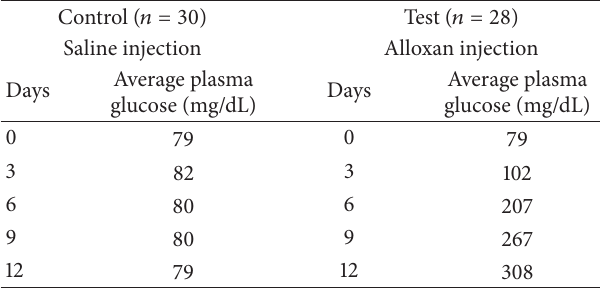
Table 1: The effect of alloxan on plasma glucose